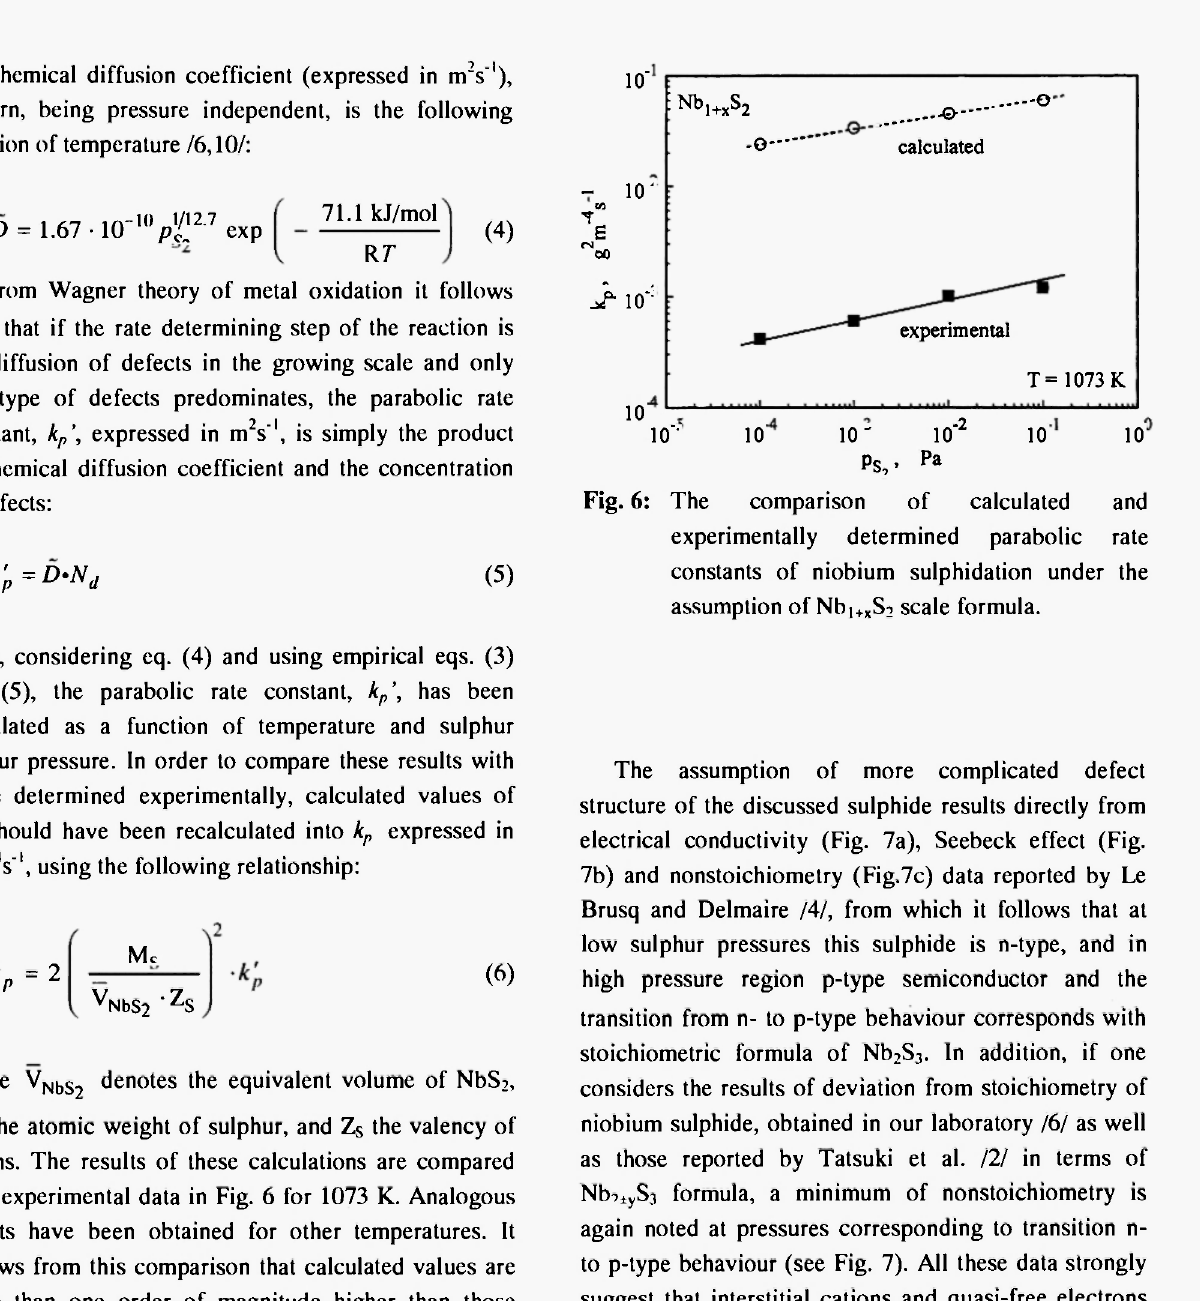
Fig. 6: The comparison of calculated and experimentally determined parabolic rate constants of niobium sulphidation under the assumption of Nb| +x S 2 scale formula.